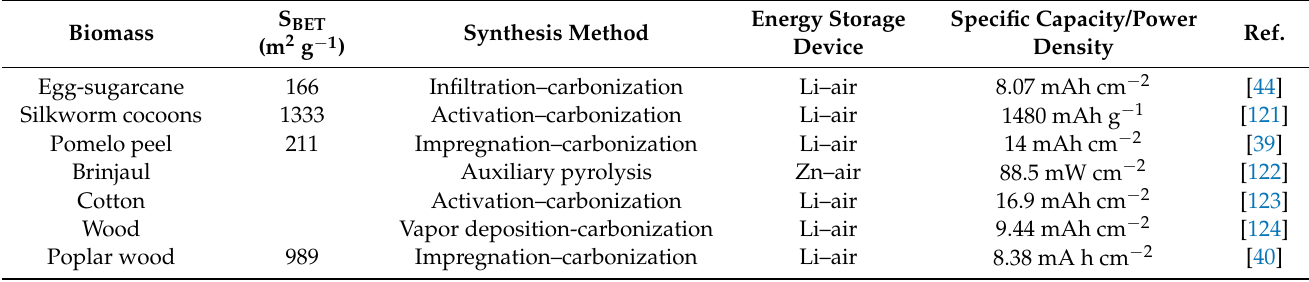
Table 2. Biochar with self-standing structure being binder-free cathode for metal–air